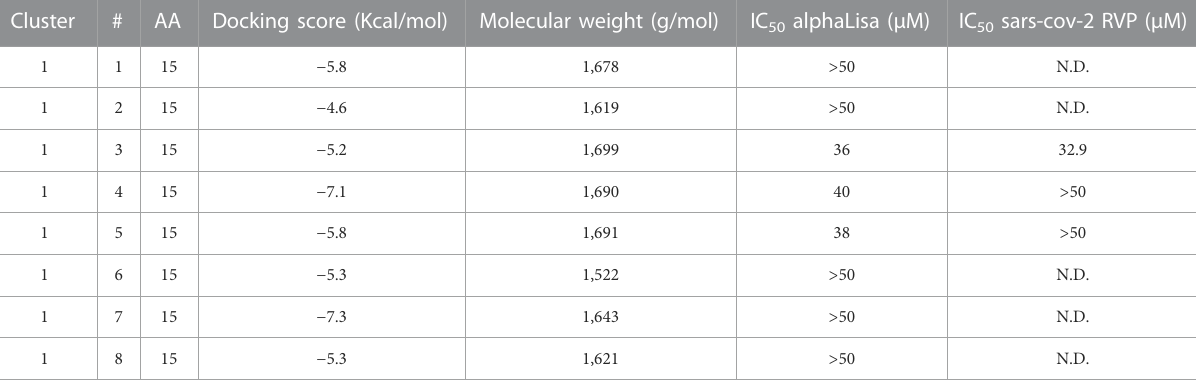
TABLE 2 Peptidomimetics designed to target ACE2 at the spike interface. Macrocycles representative of one cluster were synthesized and screened for spike RBD/ACE2 complex formation inhibition using AlphaLISA. Measured AlphaLISA IC 50 values are shown. Macrocycles showing inhibitory activity were selected for SARS-CoV-2 RVP inhibition assays. N.D. = Not Done. Values with a greater than ( > ) symbol indicate that IC 50 was not reached at maximal tested dosage.